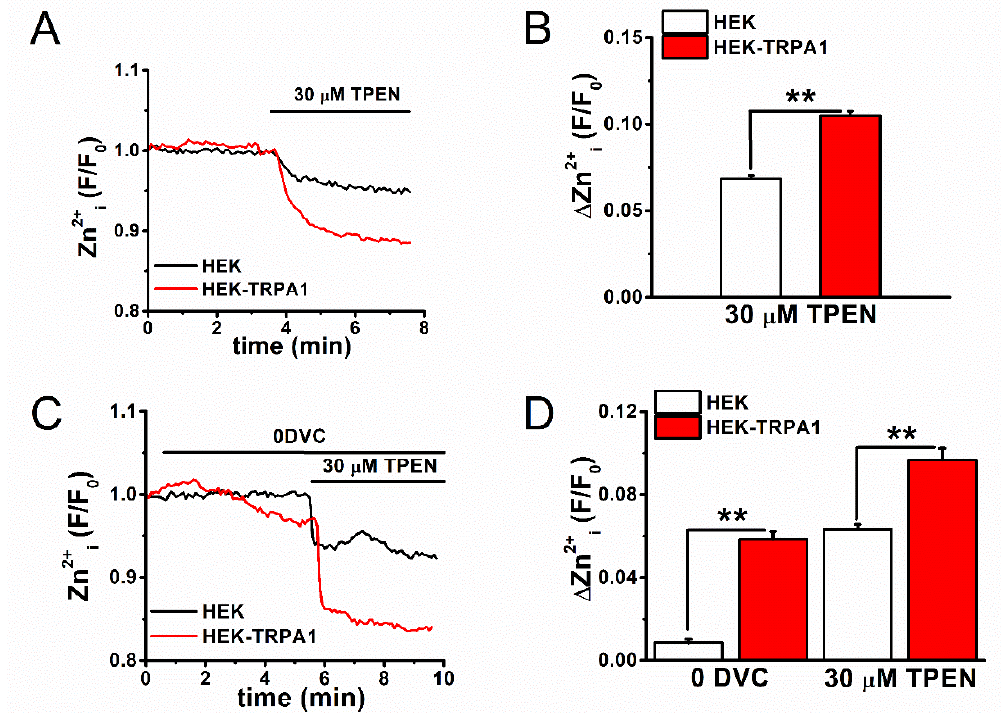
Figure 2. [Zn 2+ ] i components in HEK-TRPA1 cells. ( A ) Comparative analysis of TPEN-sensitive basal [Zn 2+ ] i components in control HEK and HEK-TRPA1 cells. [Zn 2+ ] i levels in SBS was monitored using FluoZin-3 in the presence of 30 μM TPEN. ( B ) Peak changes in [Zn 2+ ] i in the presence of TPEN (mean±SEM; n = 184 and n = 293, four and six independent experiments for control HEK and HEK-TRPA1 cells, respectively; ** p < 0.01). ( C ) Comparison of extracellular divalent cations and TPEN-sensitive basal [Zn 2+ ] i components assayed with FluoZin-3 in control HEK and HEK-TRPA1 cells. The extracellular divalent cations were removed without EGTA (0DVC), followed by exposure to 30 μM TPEN. ( D ) Peak changes in [Zn 2+ ] i in the presence of 0DVC and TPEN (mean±SEM; n = 76 and n = 78 for HEK and HEK-TRPA1 cells, respectively; two independent experiments each, ** p < 0.01).